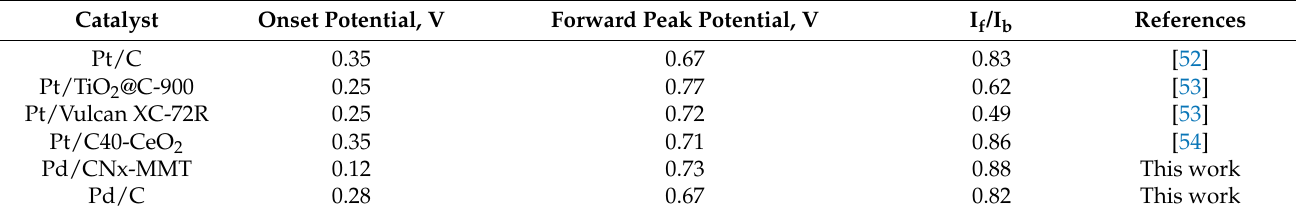
Table 1. Comparison of the electrochemical performance toward methanol oxidation between the Pd/CNx-MMT catalyst proposed in this work and Pt-based benchmark materials studied in literature at the same experimental conditions.